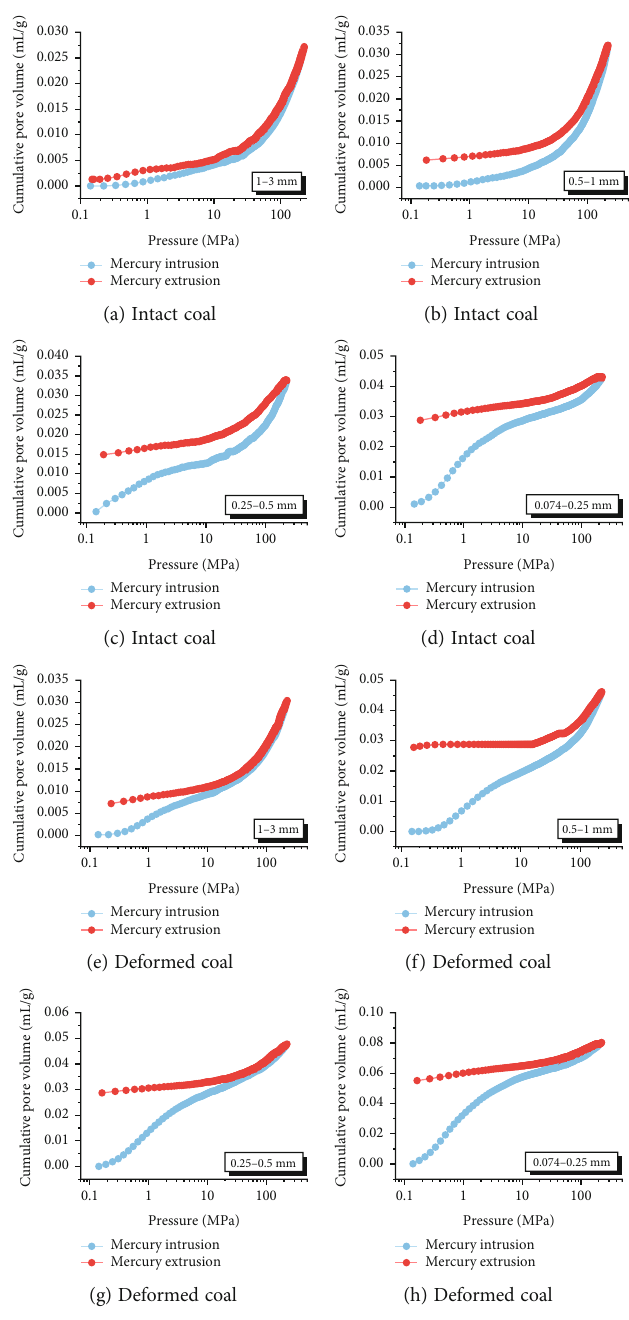
Figure 3: Mercury injection and ejection